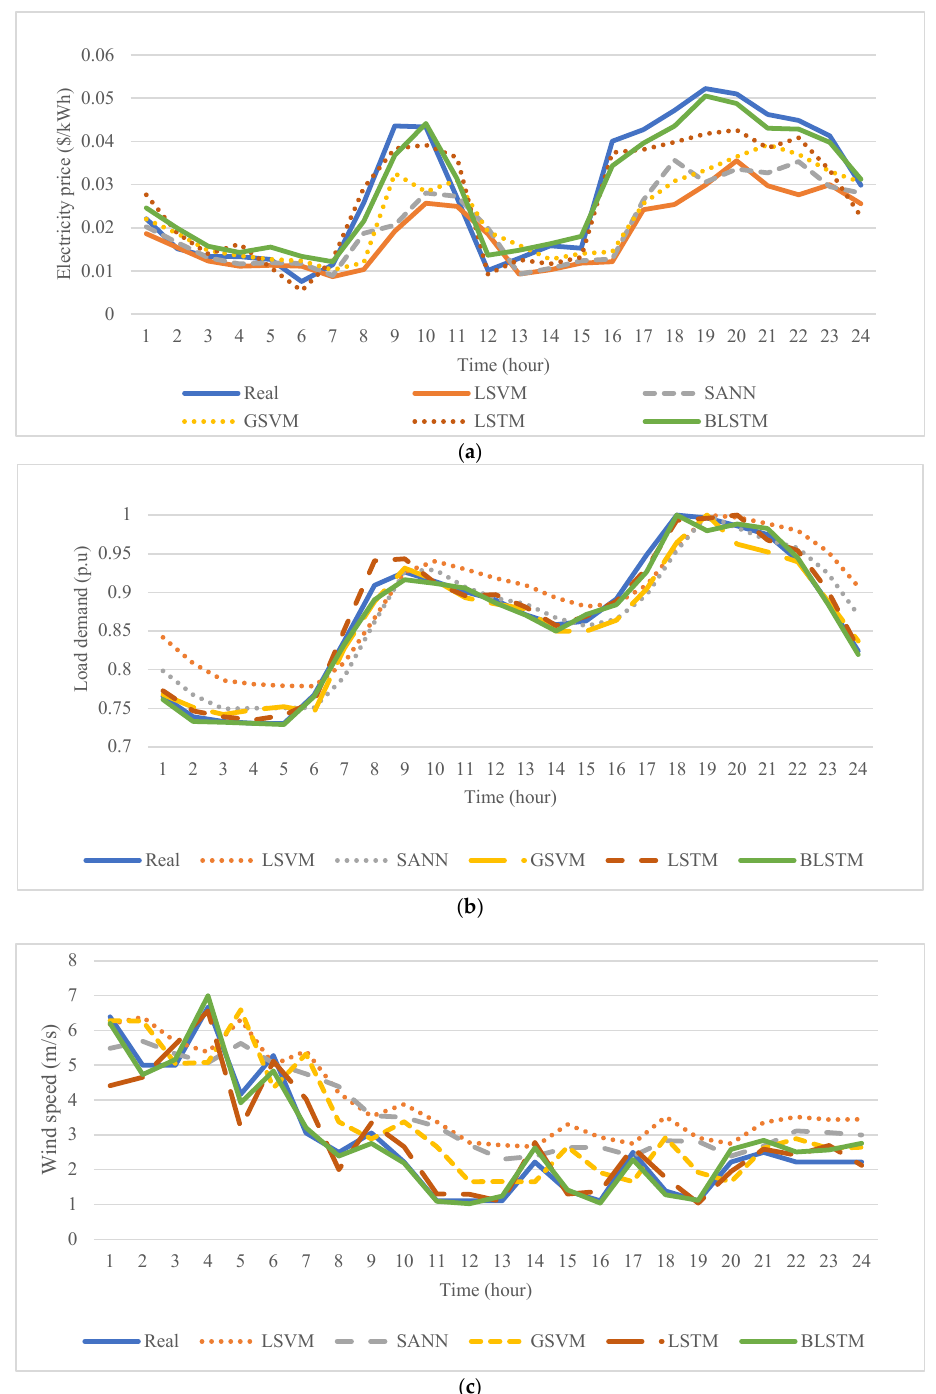
Figure 4. Forecasted values and their comparison with the real data: ( a ) electricity price; ( b ) load demand; ( c ) wind speed. Table 7. Forecasting error criteria for different methods.